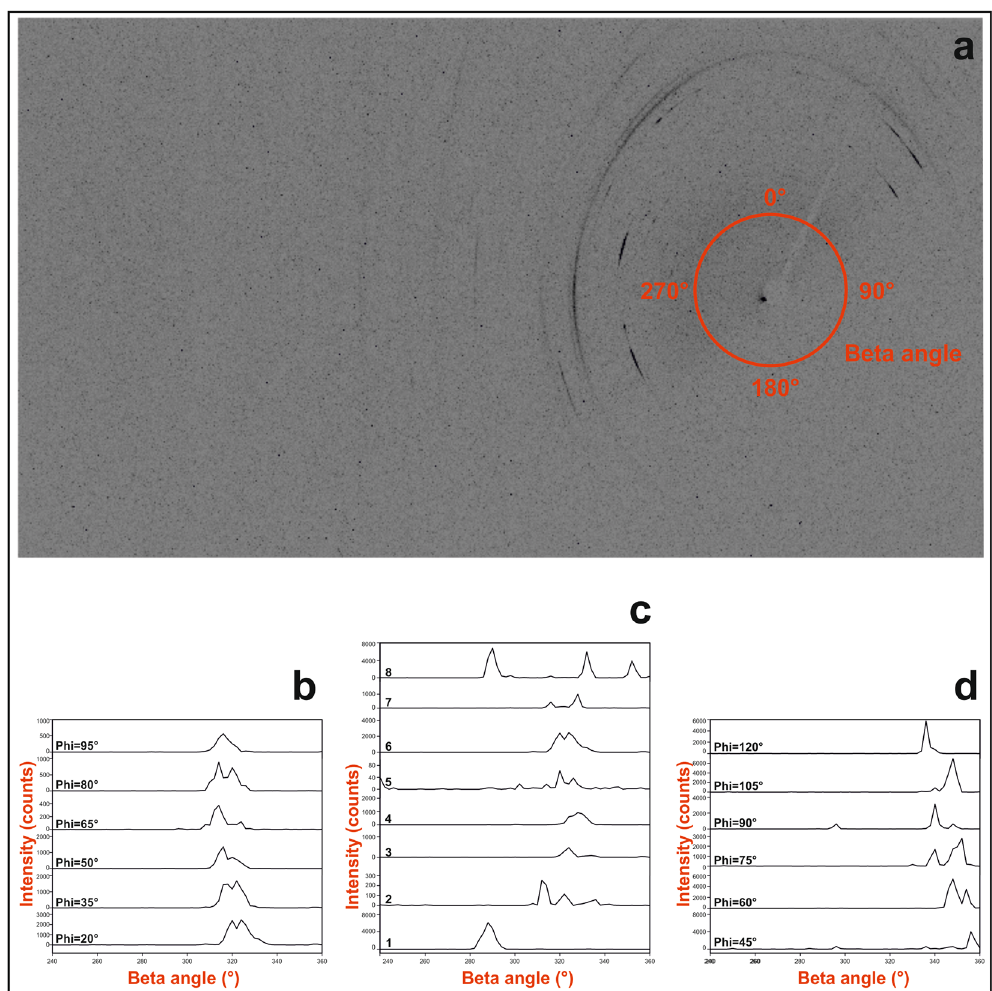
Figure 4. Crystallites preferred orientation. ( a ) Generic representation of Beta angle around the origin of the bidimensional image obtained by μ XRD measurement. ( b ) Beta-I profiles of (300) reflection obtained by μ -XRD measurement in one point (point 6 in Fig. 6) of the surface of conodont element Scabbardella altipes ; specimen IPUM 28988, sample W-BK(C)-2006. Omega angle fixed: 16°. ( c ) Beta-I profiles of (300) reflection obtained by μ XRD in eight points of the surface of Scabbardella altipes ; specimen IPUM 28988, sample W-BK(C)-2006. Omega angle fixed: 16°; Phi angle fixed: 20°. ( d ) Beta-I profiles of (300) reflection obtained by μ XRD in one point (point 6 in Fig. 6) of the surface of conodont element Amorphognathus sp., Pb element; specimen IPUM 28983, sample W4-2006. Omega angle fixed: 16°. Beta angle range was selected in order to show only where the (300) reflection was revealed